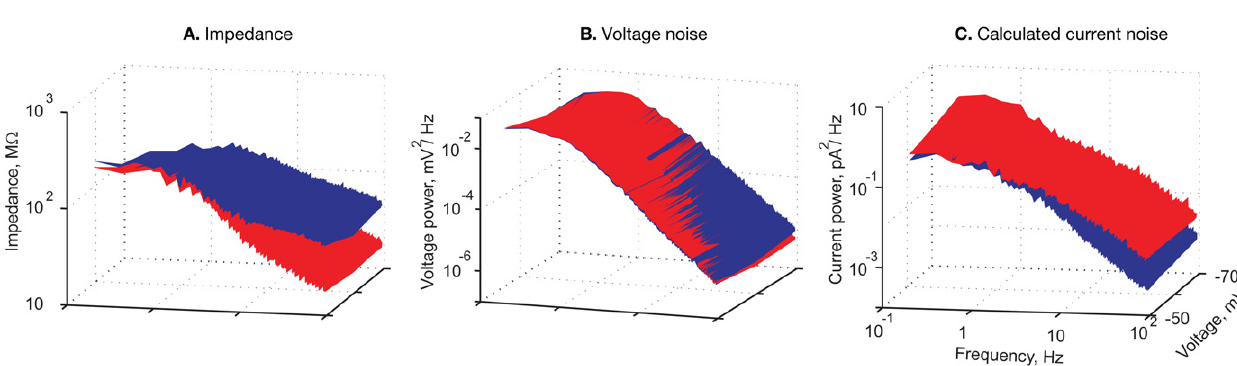
Figure 3 | The similarity of voltage noise spectra in soma and dendrites is corroborated by averaging the results across cells. (A) Average impedance (M Ω ) calculated from simultaneous recordings at the soma and the dendrite ( n = 18). (B) Average voltage noise power spectrum mV 2 /Hz of 38 soma and den- drite pair recordings. (C) Average current power spectrum (pA 2 /Hz) calculated by dividing the average voltage power spectrum in (B) by the square of the aver- age impedance in (A) . In all panels red and blue surfaces are for soma and dendrite respectively, x -axis – holding potential (mV); y -axis – log frequency